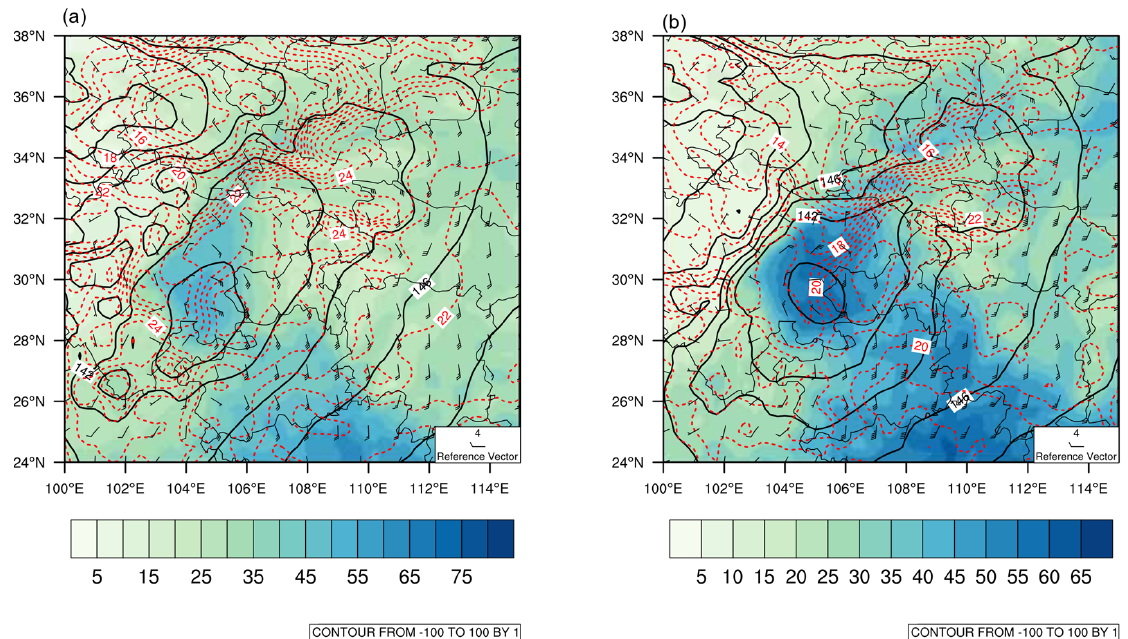
Figure 1. Geopotential height (black solid lines; units: gpm), temperature (red dotted line, units: K) and wind fields (wind barbs), and precipitable water (shaded; units: mm) at ( a ) 1200 UTC and ( b ) 1800UTC 4 June 2019.